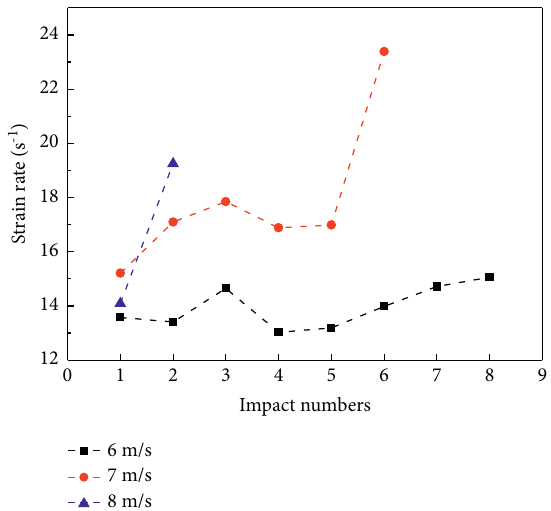
Figure 5: Average strain rate with the increase of impact numbers under diferent impact velocities.